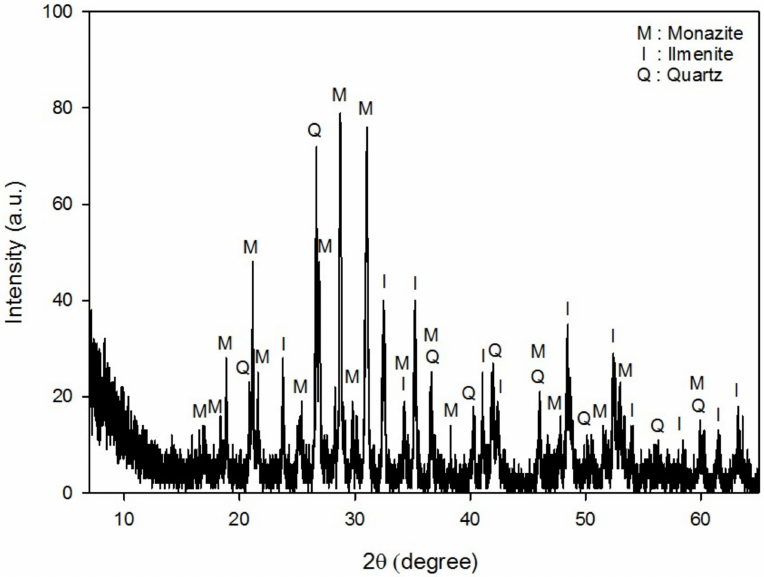
Figure 2. X-ray diffraction (XRD) patterns of the feed